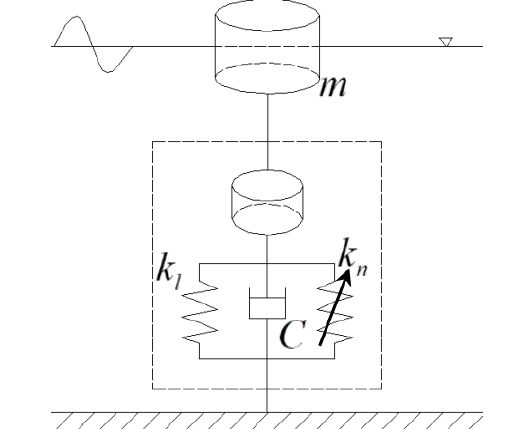
Fig. 1. PA-WEC with nonlinear hardening spring PTO